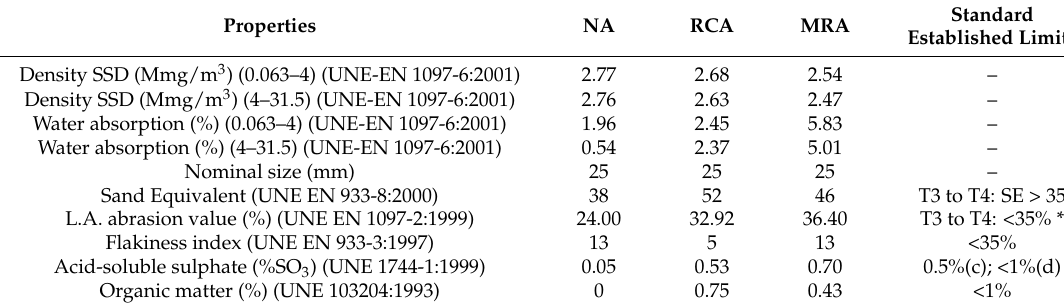
Table 1. Properties of the natural and recycled aggregates.